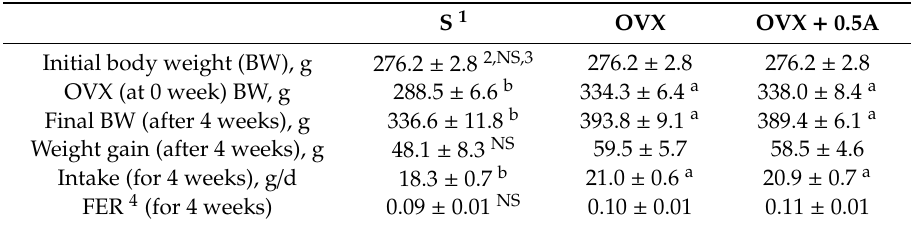
Table 1. E ff ects of A. pilosa on body weight, weight gain, food intake, and FER of rats.